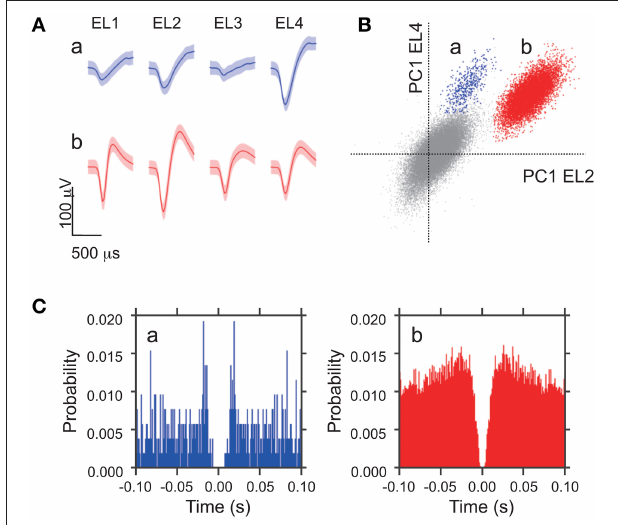
FIGURE 1 | Waveform characteristics of two representative amygdala neurons. (A) Waveforms (mean ± SD, shaded) simultaneously recorded from the four tetrode leads (EL 1–4). The waveforms indicated by a and b correspond to the two clusters in (B) . (B) The results of an offline cluster analysis. Each dot represents one spike. The horizontal axis represents the first principle component (PC 1) of EL 2, and the vertical axis represents PC 1 of EL 4. (C) Autocorrelograms of neurons a and b. Autocorrelograms of neurons a and b show that refractory periods of the neurons were greater than 2ms, consistent with these spikes originating from single neurons. Bin width =